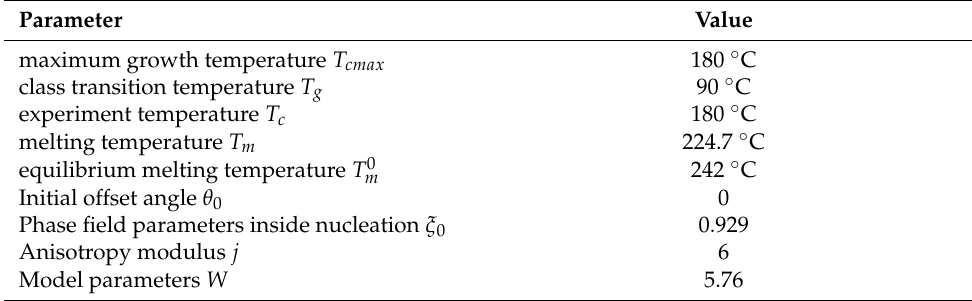
Table 1. The parameter values required for simulation are shown in the following table.